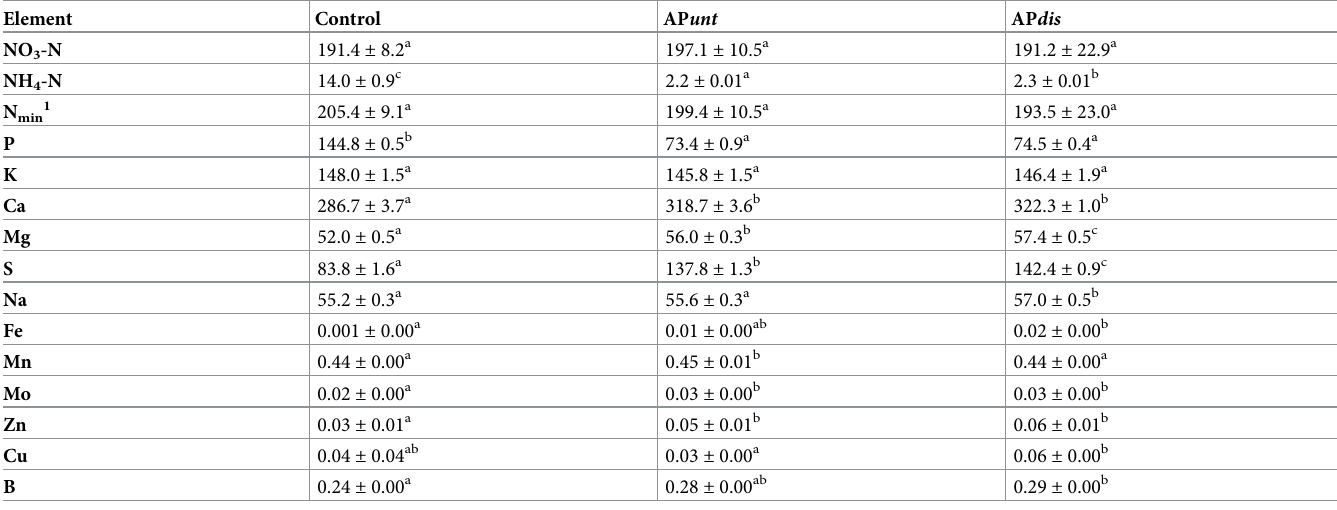
Table 4. Nitrogen and mineral concentrations of the nutrient solution in mg L -1 at the beginning of the experiment used for control and both aquaponic treatments. The data represent the mean concentrations of nutrients in the three different nutrient solutions ± standard deviation measured after the nutrient solutions were mixed and completely prepared before the experiment started. The control was prepared with fresh and rain water (50:50, v/v), AP unt and AP dis were prepared with fish water. While AP unt was untreated, AP dis was disinfected. The data was compared and tested using univariate ANOVA and post hoc tests Tukey-HSD test or using Kruskal-Wal- lis (Cu) and Dunn-Bonferroni (Fe, Mo, B) test. Different superscript small letters indicate significant differences between the treatments (p <